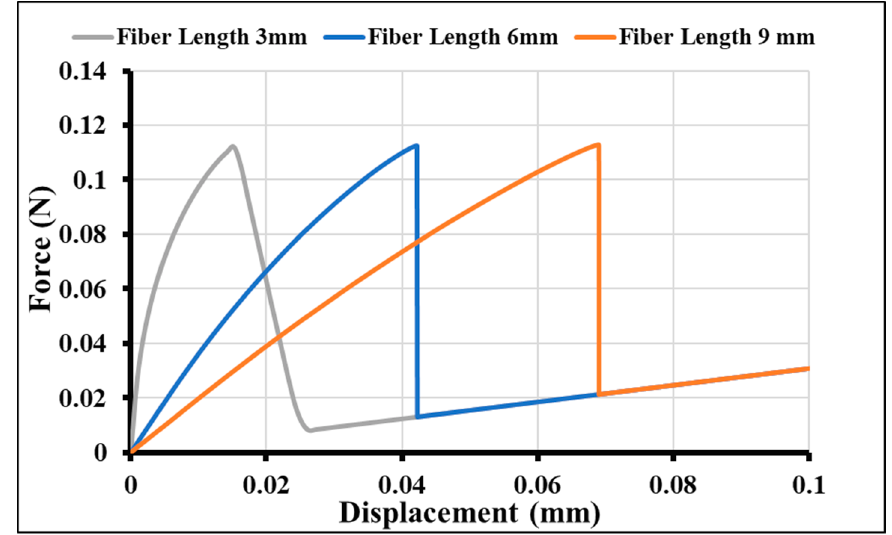
Figure 7. Force-displacement curve for varying fiber length.